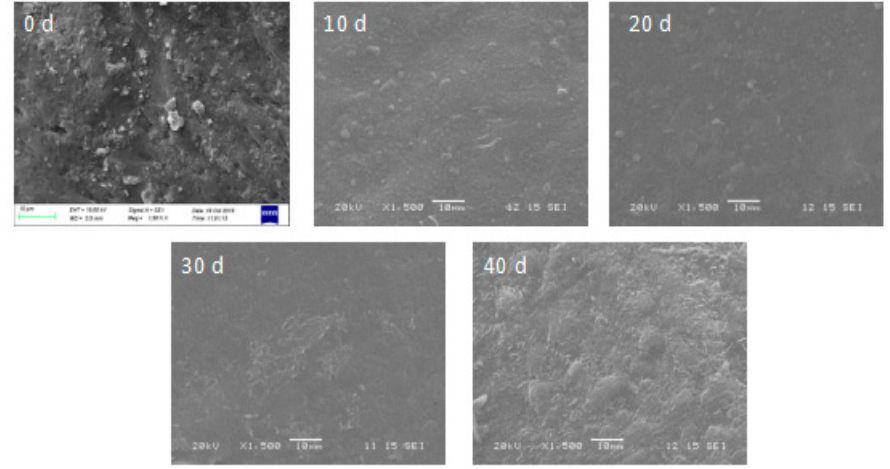
Figure 4. Epicuticular wax crystal structure of the ‘Satsuma’ mandarin fruits during storage for 40 days was detected at ×1500 magnification.